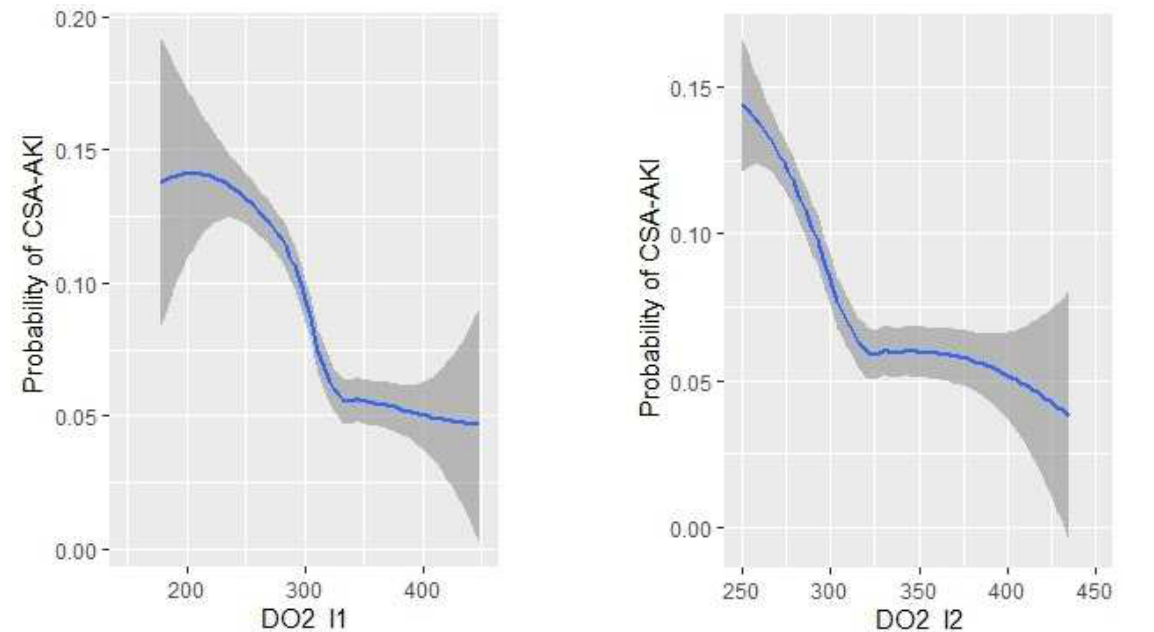
Figure 2. Relationship between DO 2 i and CSA-AKI both during the surgery and at the end of the intervention. intervention.